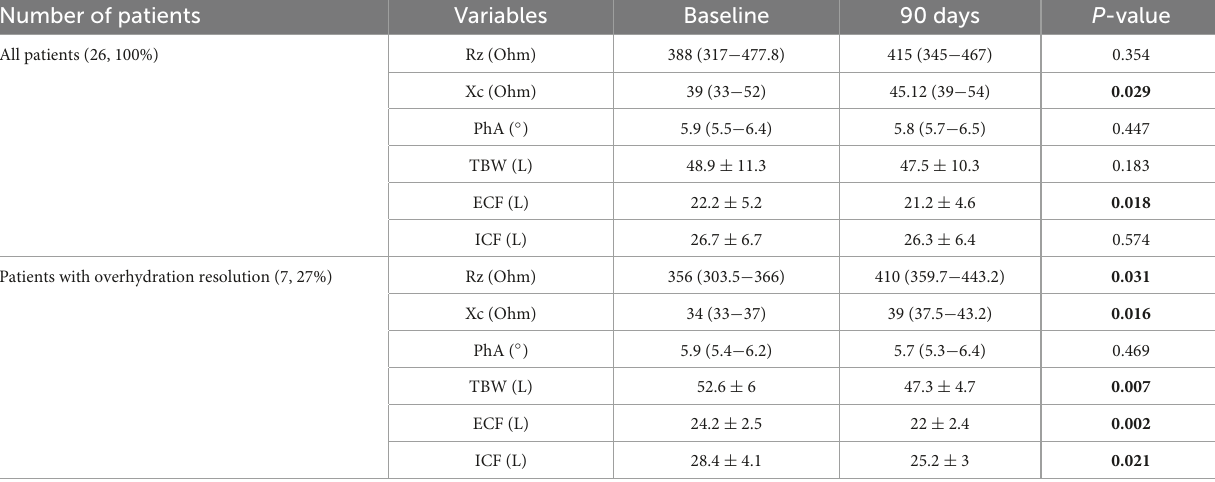
TABLE 3 Measured bioimpedance parameters and estimated body fluid composition at both baseline and end of study in all patients and, particularly, in those who achieved significant resolution of overhydration condition on Biavector. Number of patients Variables Baseline 90 days P -value All patients (26, 100%) Rz